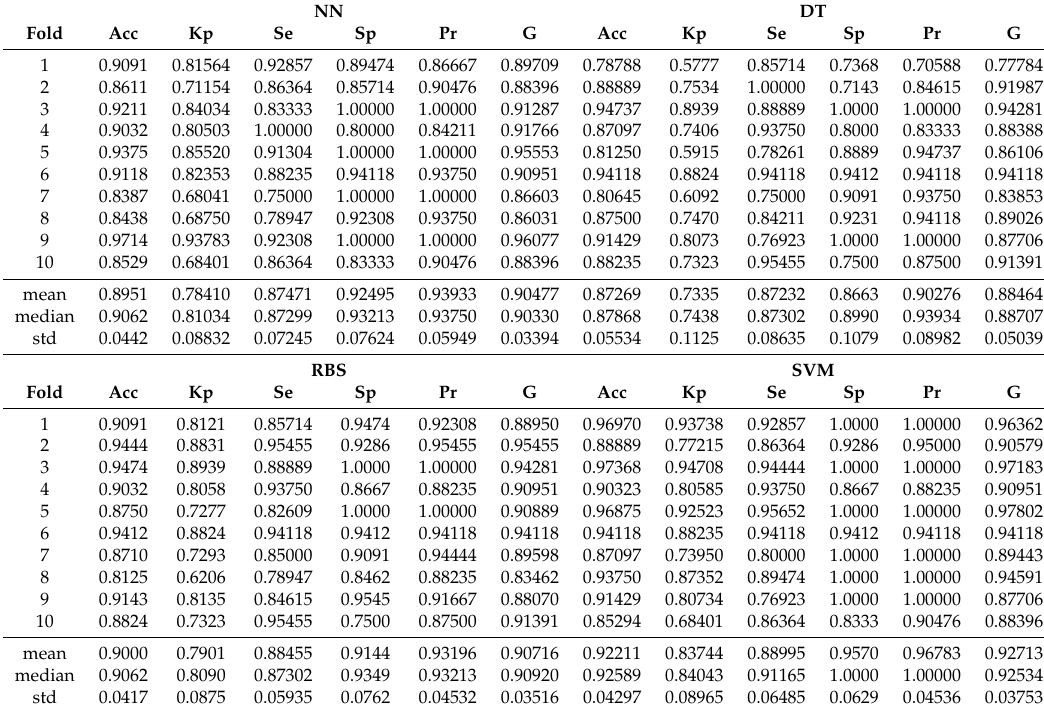
Table 7. Results obtained from the 10-fold cv when the threshold is set to 2.5 × g : the different statistics are the Accuracy (Acc), Kappa factor (Kp), Sensitivity (Se), Specificity (Sp), Precision (Pr) and the Geometric mean (G), all of them computed using Equations (1) to (8). The models are feed forward NN, Support Vector Machine (SVM), decision trees learned with C5.0 (DT) and Rule-Bases systems learned with C5.0 (RBS).